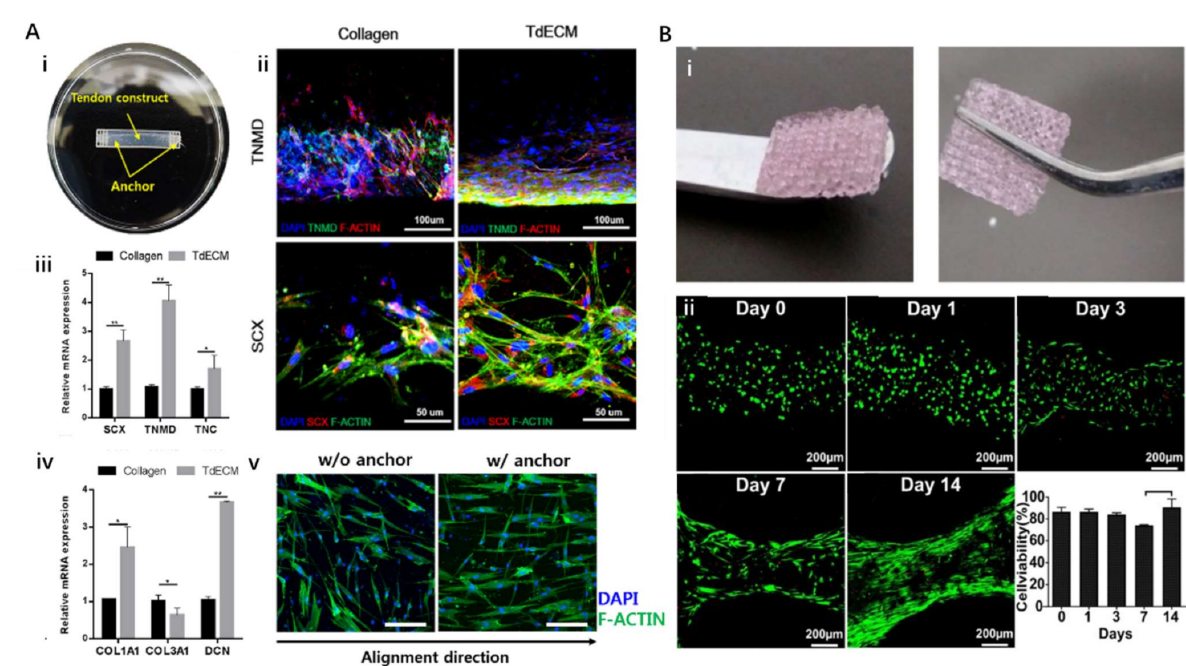
Figure 5. Three-dimensional bioprinting of tendons and ligaments. ( A ). ( i ) A 3D bioprinted tendon construct; ( ii ) comparison of immunofluorescence staining against TNMD and SCX in 3D bioprinted tendon constructs using collagen and TdECM on day 7; ( iii , iv ) relative mRNA expression of tendon-specific and ECM genes in tendon constructs in collagen and TdECM groups at day 7; ( v ) confocal fluorescence images of tendon constructs at culture day 14 without and with anchor (scale: 50 µ m). ( B ). ( i ) Thermally crosslinked 3D bioprinted GelMA hydrogel scaffolds; ( ii ) viability of periodontal ligament stem cells embedded in the 3D bioprinted constructs during 14 days. (*, p < 0.05, **, p < 0.05). Reproduced with permission from Refs. [133,138] with slight changes